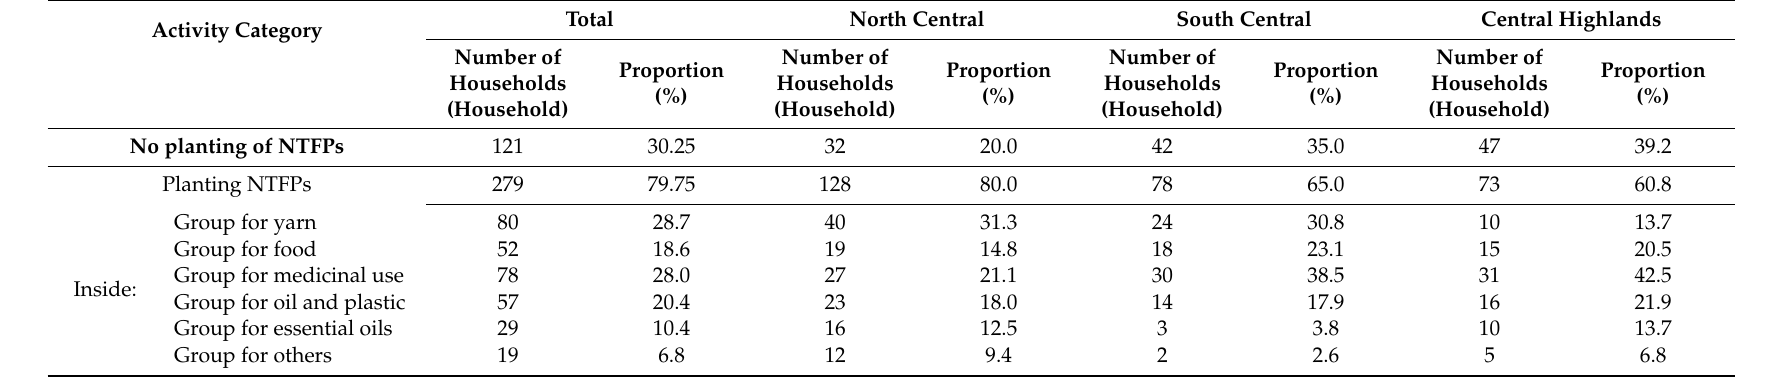
Table A1. Participation of farmers’ household in NTFP